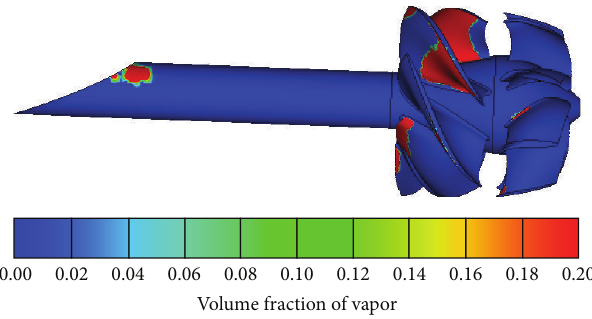
Figure 13: Volume fraction of vapor contours on the rotating shaft, rotor, and